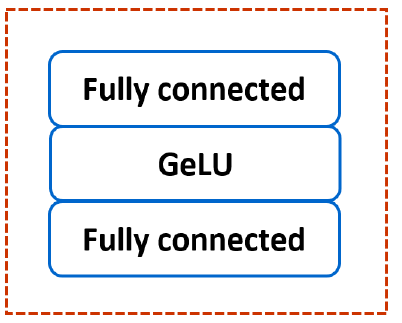
Figure 6. The architecture of the multi-layer